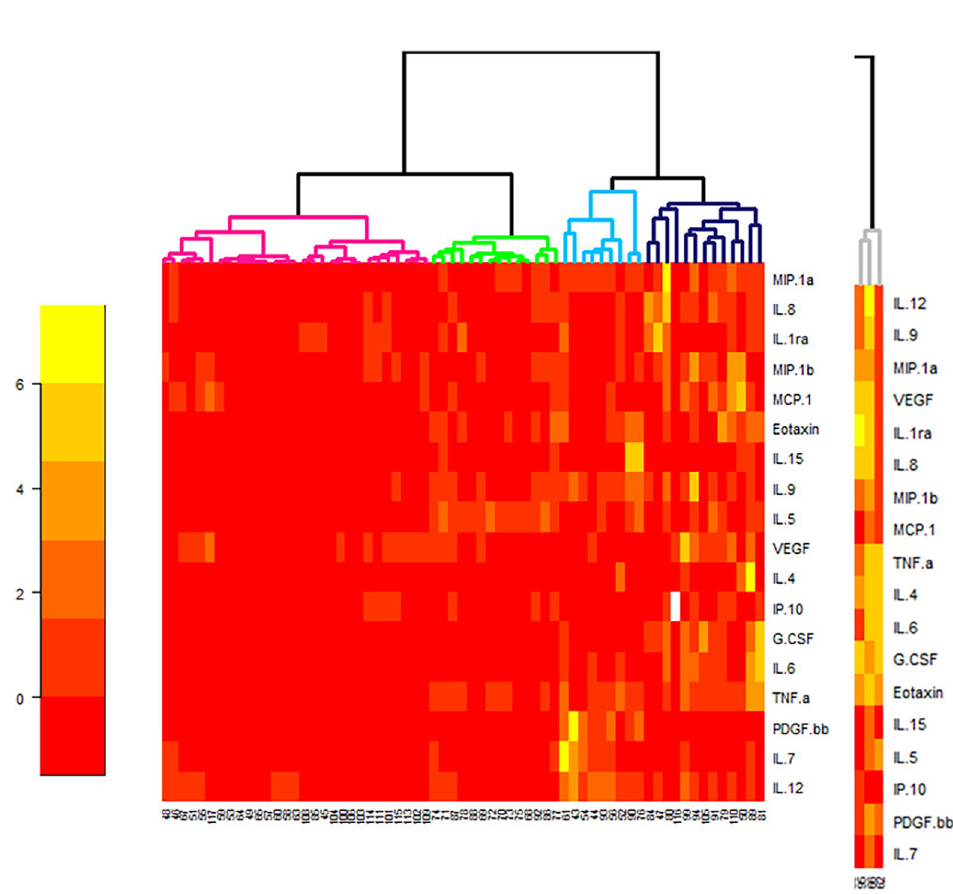
Fig 8. Heat map analysis comparing aqueous humor cytokine concentrations in 64 the idiopathic uveitis samples and 47 non-inflammatory controls (age-related cataracts). Only significant different cytokines in idiopathic uveitis compared with controls were considered. Cytokine concentrations are depicted as colors ranging from red to orange to yellow, indicating low, intermediate, and high concentration, respectively, relative to the mean cytokine concentration. The phenotype of the samples is indicated by the label on the right as well as by the colored bar on the top. Samples are separated in one of four clusters (pink, green, blue and black) indicated on the top.